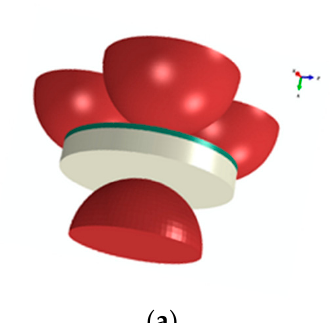
( b ) Figure 10. Results of uniaxial compression of a Si 3 N 4 -cylinder with SplitP TPMS structure: ( a ) homogenized true stresses of the cross section and uniaxial mean strain by means of the dimensions; ( b ) fitted elasticity to stress-strain results. 3.5. Finite-Element-Modeling and Reliability Calculations 3.5.1. Discs for Ball-on-Three-Balls Test and Calculation of Weibull-Parameter The calculation of stress in the B3B test was already provided by Börger et al. [45]. However, to calculate the effect of structures on surfaces, of elasticity gradients, of geometric deviations and, based on the load, the effective volume necessary for the reliability calculation, own simulation sets were built. Here, the loading by the spheres